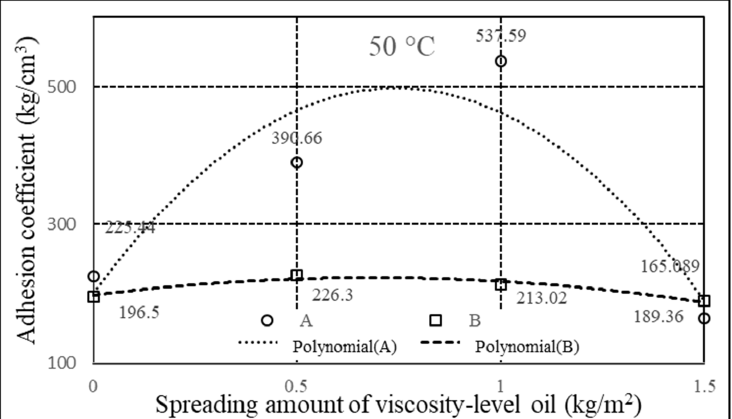
Figure 16. Adhesion coefficient curve of viscosity-level oil A and B specimens at 50 °C.